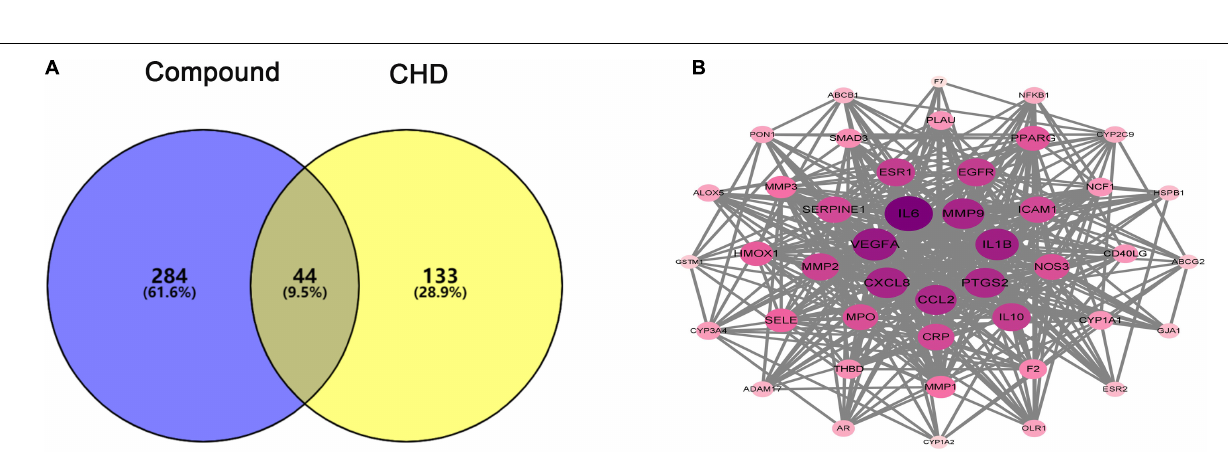
Frontiers in Cardiovascular Medicine |